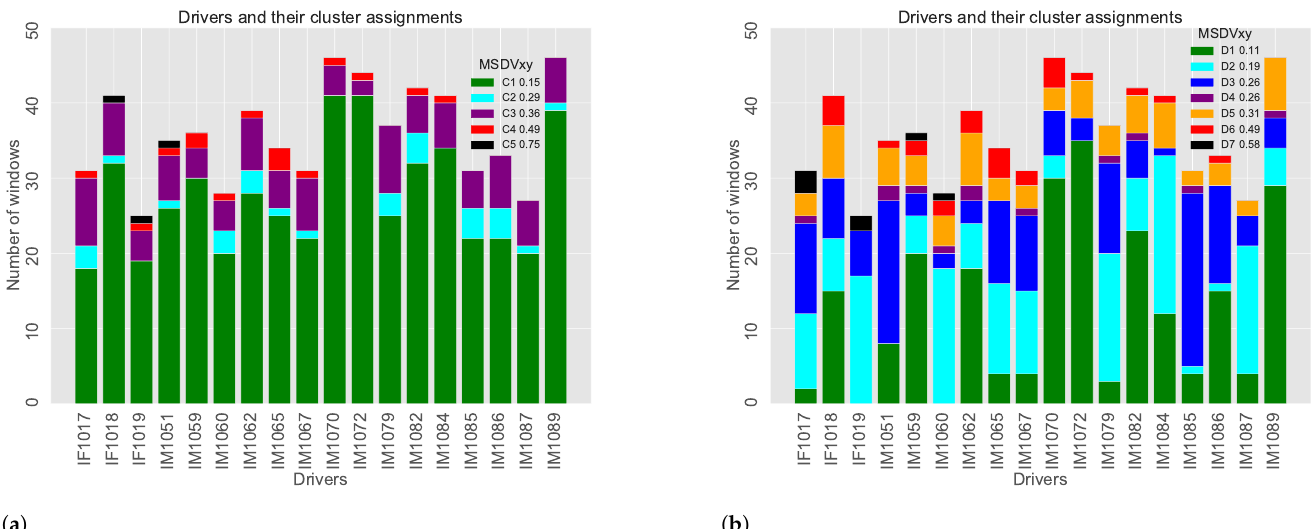
Figure 9. Cluster assignments from the chosen model created after using the RFE feature selection ( a ), C i clusters of Solution 1) or PCA ( b ), D i clusters of Solution 2) on the driver-controlled variables. Each vertical bar represents one driver, starting with IF1017 and ending with IM1089; the bar represents how many points from each driver belongs to what cluster. This allows us to visualize the distribution of each driver and its comparison to others.